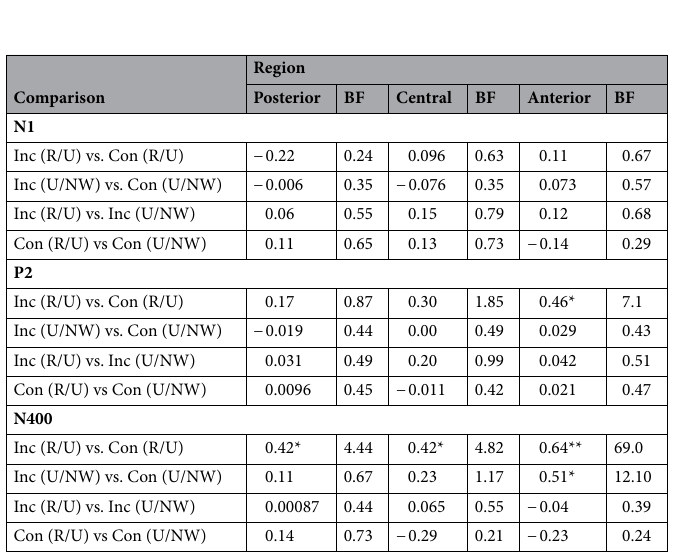
Table 1. Spearman correlations between different priming effects and Bayes Factor (BF) values. Inc inconsistent, Con consistent, R/U related vs. unrelated primes, U/NW unrelated vs. nonwords primes. *p < .05, **p <